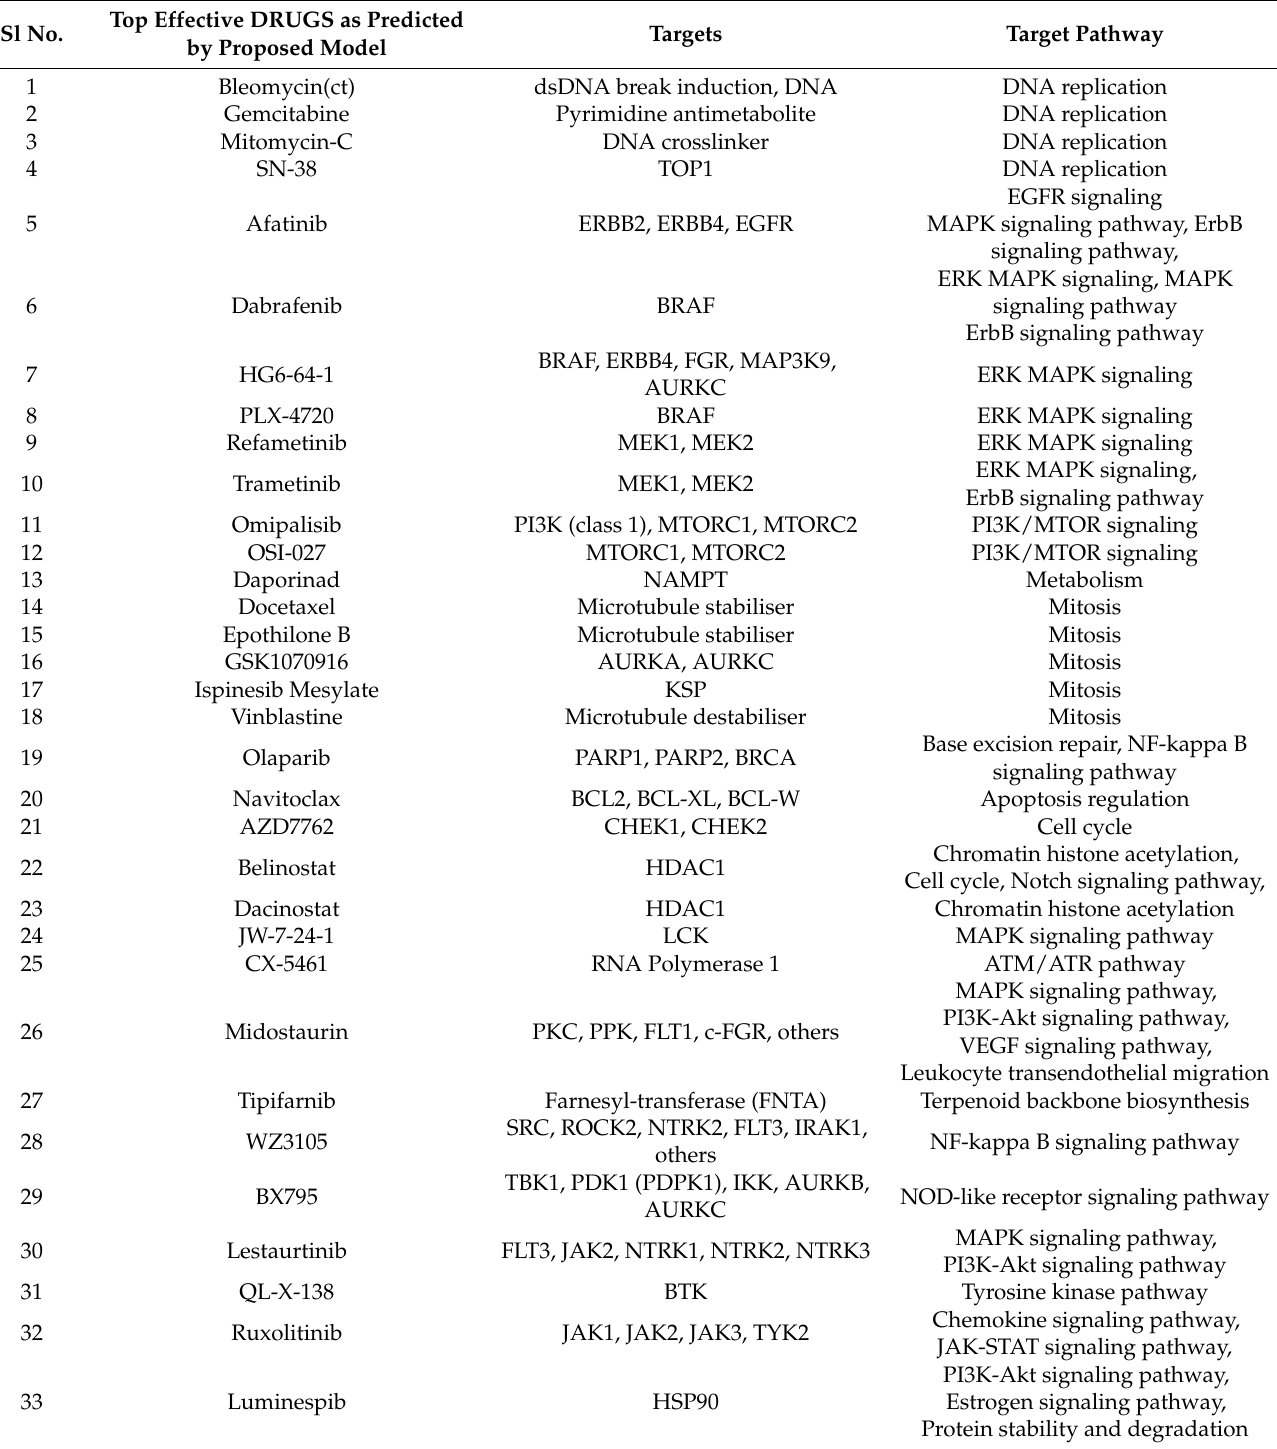
Table 5. Summary of effective drugs predicted by